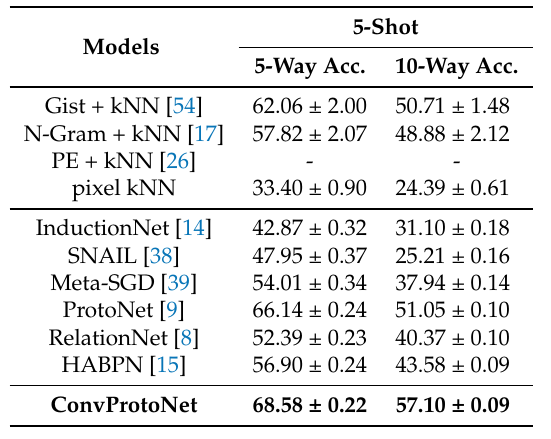
Table 3. Test accuracy and 95% confidence interval for malware few-shot classification on Drebin dataset. Drebin contains Android applications thus PE meta-data experiments are not reported. Bold items indicate the highest accuracy among all models under the same experiment setting.